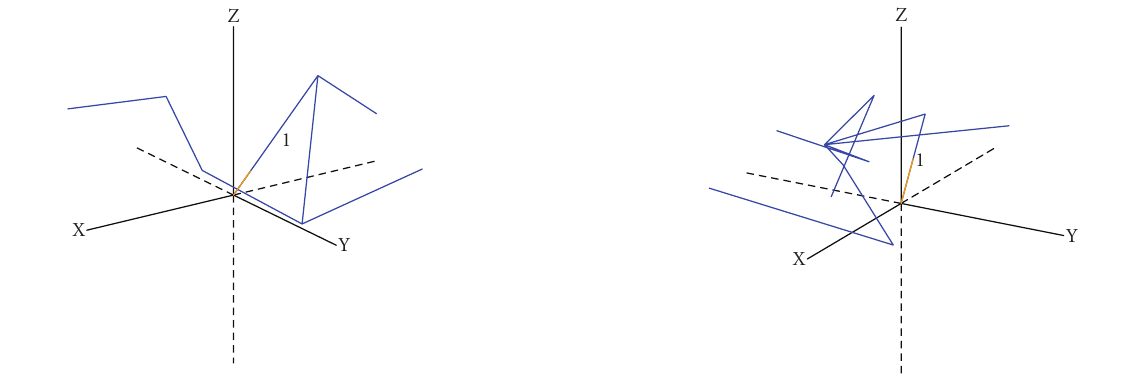
Figure 5: A GP-optimized multibranch antenna with C = 57. Figure 6: A GP-optimized complex-geometry antenna with C = 20.